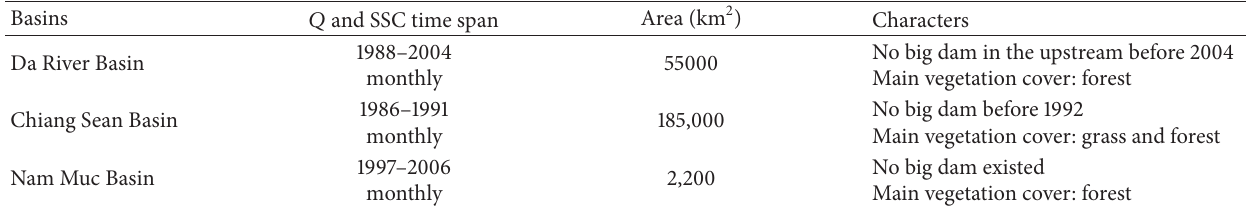
Table 1: Basic characters of our selected